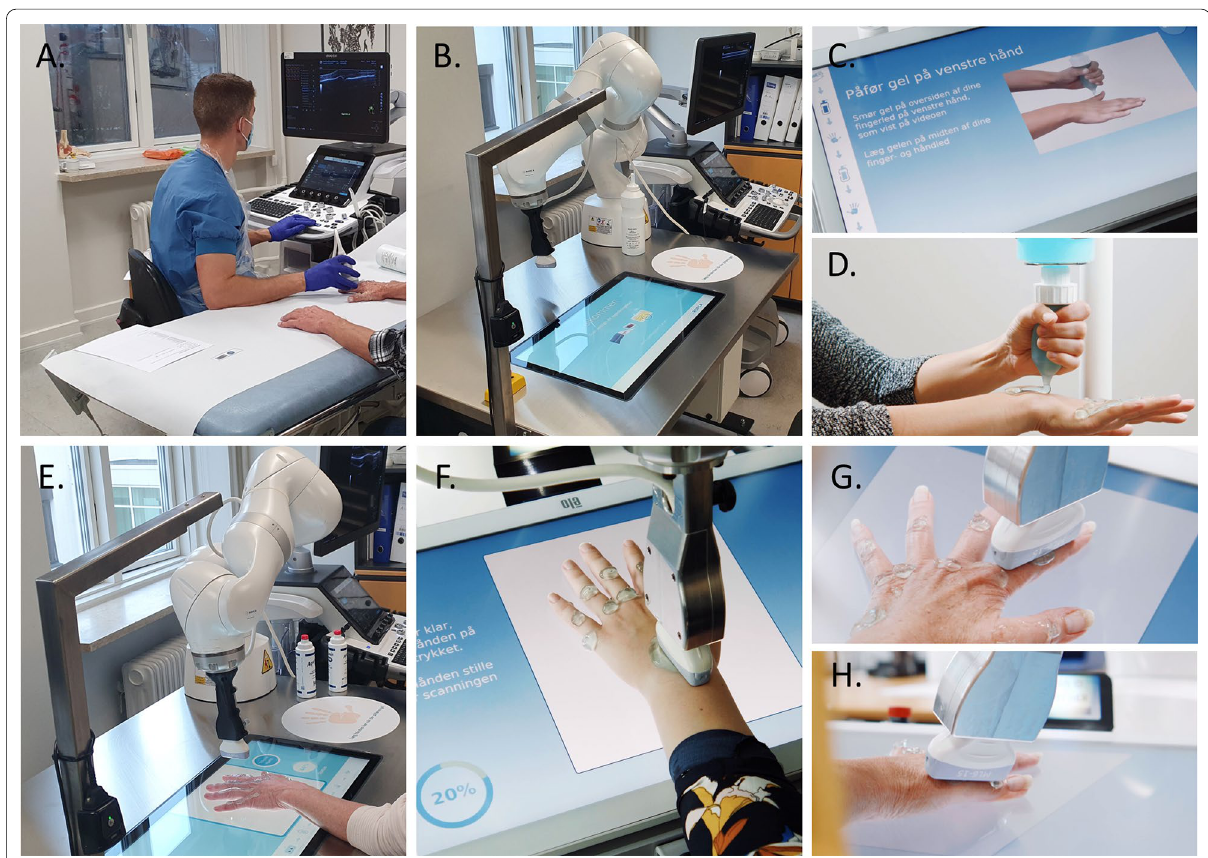
Fig. 1 A The rheumatologist performs the first ultrasound examination. B The ARTHUR system used in this trial used a GE Logiq 10 ultrasound scanner. C The patient scans their ID card and receives instructions by both audio and on the touchscreen on how to proceed. D The patient places ultrasound gel on one hand. E ARTHUR starts to ultrasound scanthe patient. ARTHUR instructs the patient when its time to remove the gel and place ultrasound gel on the other hand. F ARTHUR scans the wrist joint, see also Fig. 2. G ARTHUR ultrasound scans a PIP joint. H